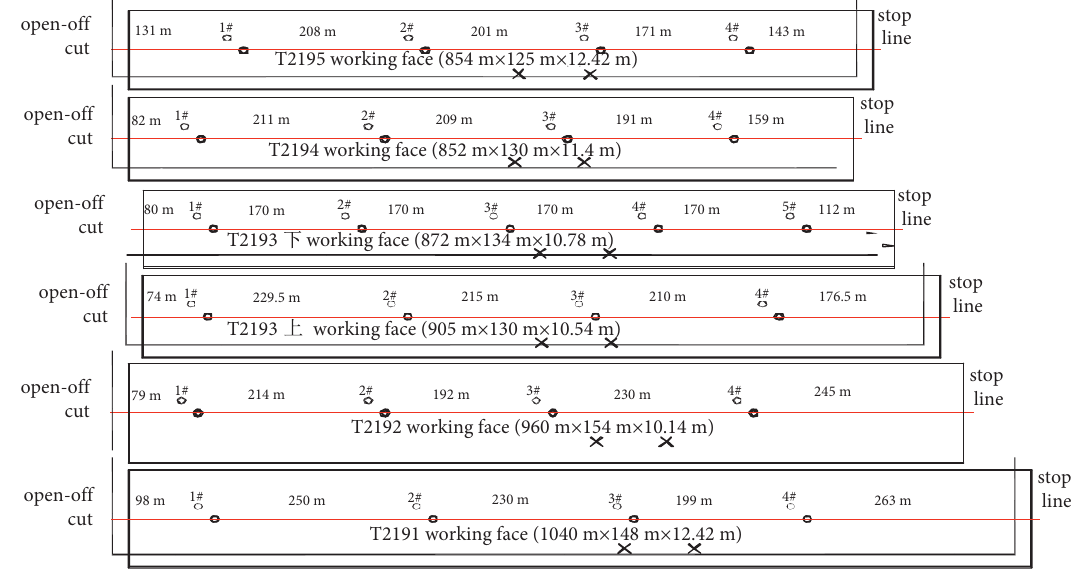
Figure 9: Schematic diagram of borehole layout in the second mining district.